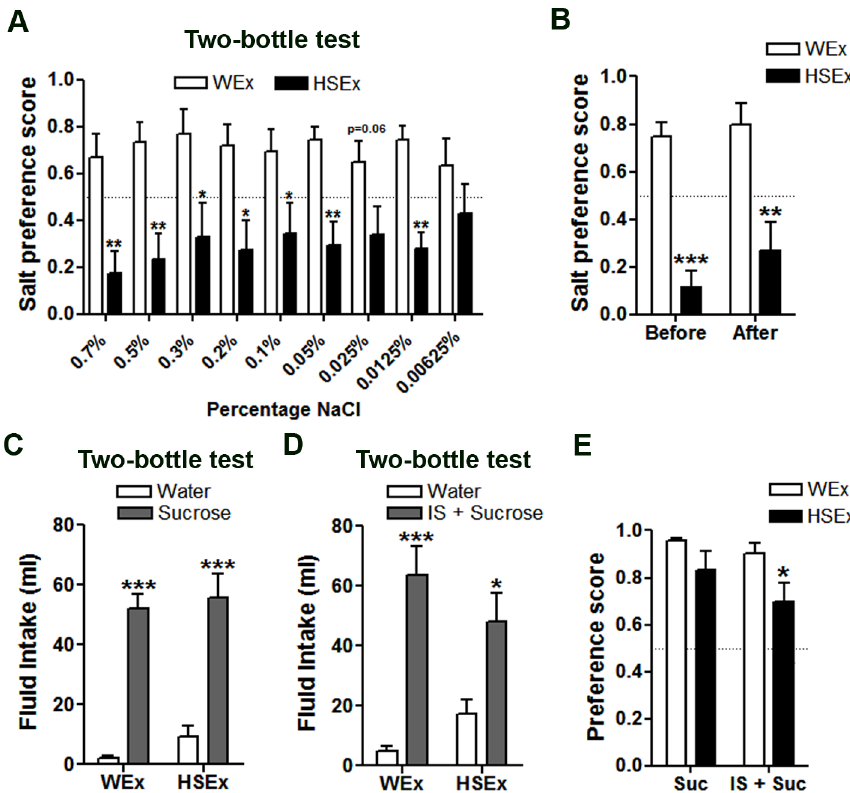
Figure 3. A significantly reduced appetite for salt solutions following a single 24 h one-bottle test with HS. A, Mean preference scores have been calculated from 24 h measures of water and salt intake at the percentage shown for WEx and HSEx rats. B, mean preference score for IS on day 9 (before tests) and day 30 (after tests). C, mean intakes of 1% sucrose solution compared to water in 24 h two-bottle choice test. D, mean intakes of 1% sucrose prepared in IS in 24 h two-bottle choice test with water. E, mean preference scores calculated from the fluid intake data in C and D. Values are means + SEM of n=8 animals per group. *p , 0.05, **p , 0.01, ***p , 0.001. HS, hypertonic saline. HSEx, hypertonic saline exposed; IS, isotonic saline; Suc, sucrose; WEx, water